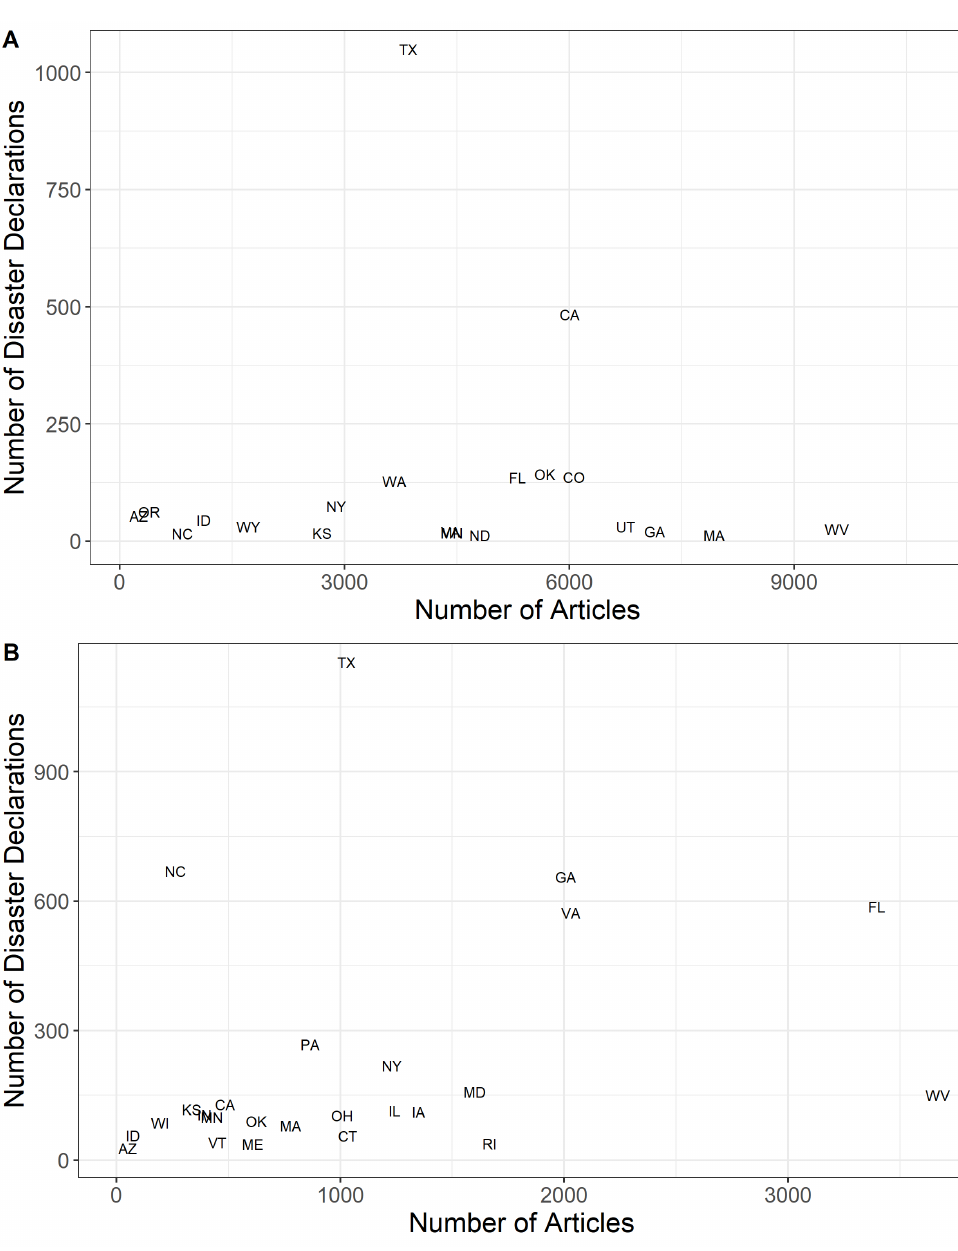
Figure 5. State-Level Proximity Associations for ( A ) Fires and ( B ) Hurricanes. Point labels indicate two-letter state abbreviations. Hurricane-related declarations and coverage have a higher correlation (0.3 τ , 0.04 p -value) than fire-related declarations and coverage (0.01 τ , 0.9 p -value). Significant spatial clustering of fires is observed in some of the western counties; for example, there are hotspots in Arizona, southern California, and central Oregon for fire frequency (Figures 6 and A7), while Ventura County in California and north-central Oregon emerge as hotspots for fire sizes (Figure A8). Another distinction between the regions is the underlying causes of the fires; more fires have human causes in the northeast than in the west (Figure A5). Spearman correlations at the state-level indicate that more properties are at risk for wildfires in the west (Figure A3); these states correlate strongly with the number of wildfire-related articles present ( ρ = 0.60, p -values: